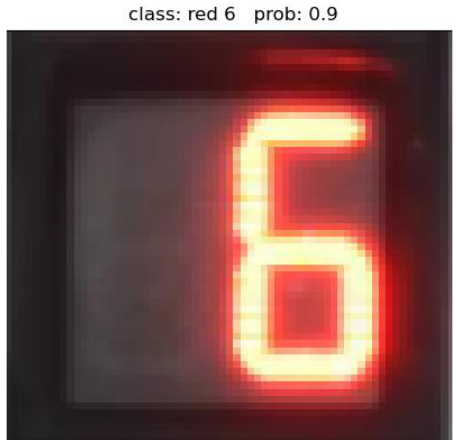
Figure 19. Validation result 2.